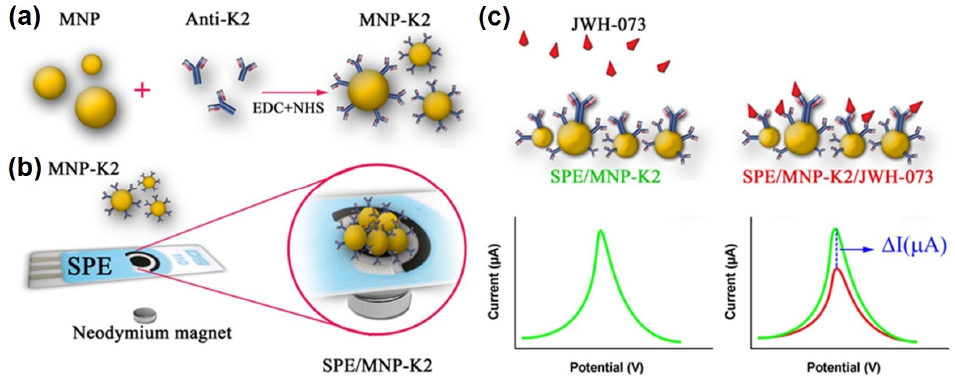
Figure 11. ( a ) Conjugation of MNPs with anti-K2 antibody. ( b ) Capture of MNP-K2 on the screen- printed electrode (SPE) of the sensors via magnetic force. ( c ) Reduction of the electrical current by the presence of JWH-073. Adapted with permission from reference [40]. Copyright 2020 American Chemical Society.